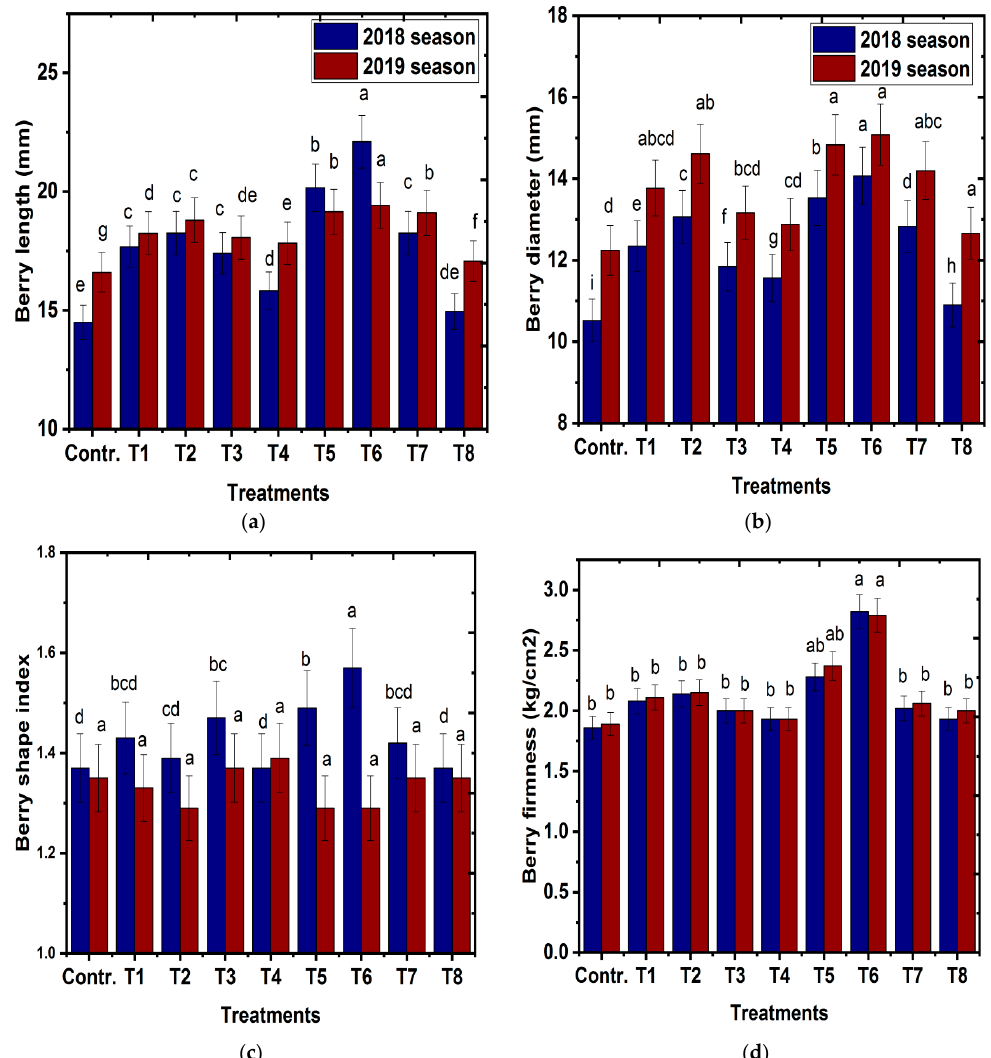
Figure 7. Effect of hand thinning and GA 3 spray sizing on ( a ) berry length, ( b ) berry diameter, ( c ) shape index of and ( d ) berry firmness of Sultanina grapevines (H4 strain) in 2018 and 2019 seasons. Contr. without removing any shoulders of the cluster, T1:25% hand thinning + 20 ppm GA 3 sizing, T2:25% hand thinning + 30 ppm GA 3 sizing, T3:25% hand thinning + 40 ppm GA 3 sizing, T4:25% hand thinning Without GA 3 sizing, T5:50% hand thinning + 20 ppm GA3 sizing, T6:50% hand thinning + 30 ppm GA 3 sizing, T7:50% hand thinning + 40 ppm GA 3 sizing and T8:50% hand thinning without GA 3 sizing. Means in each column followed by the same letter (s) are not significantly different at ( p ≤ 0.05), using Duncan’s Multiple Range Test.